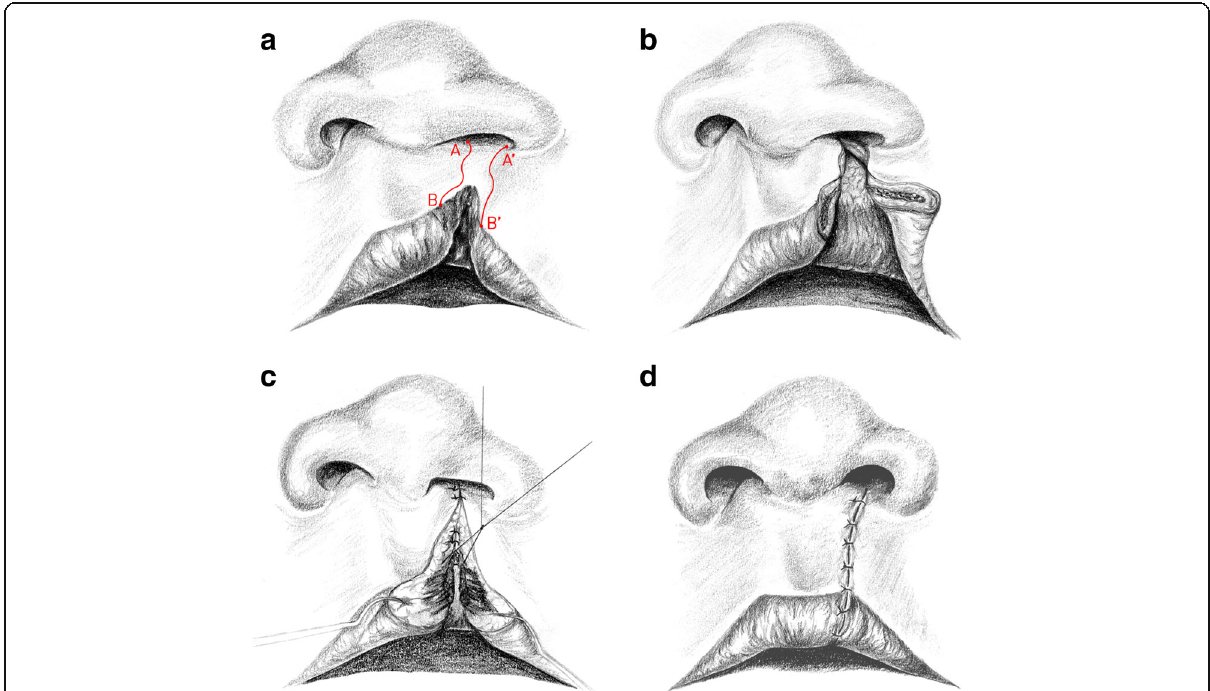
Fig. 1 Operation method according to Pfeifer. a The planned red wave cuts A to B and A ′ to B ′ have the same length on both sides when they get stretched. b The orbicularis oris muscle is mobilzed from his wrong insertion on both sides subcutan and submucosally. c Reconstruction of the orbicularis oris muscle. d Result after wound closure (A to A ′ and B to B ′